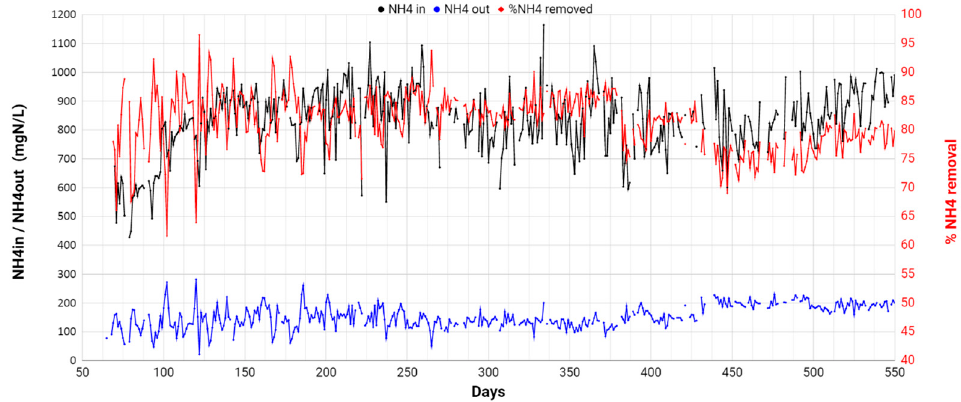
Figure 11. NH 4 level in the inlet and outlet of the ANITA Mox at Wrexham and percentage of NH 4 removed.